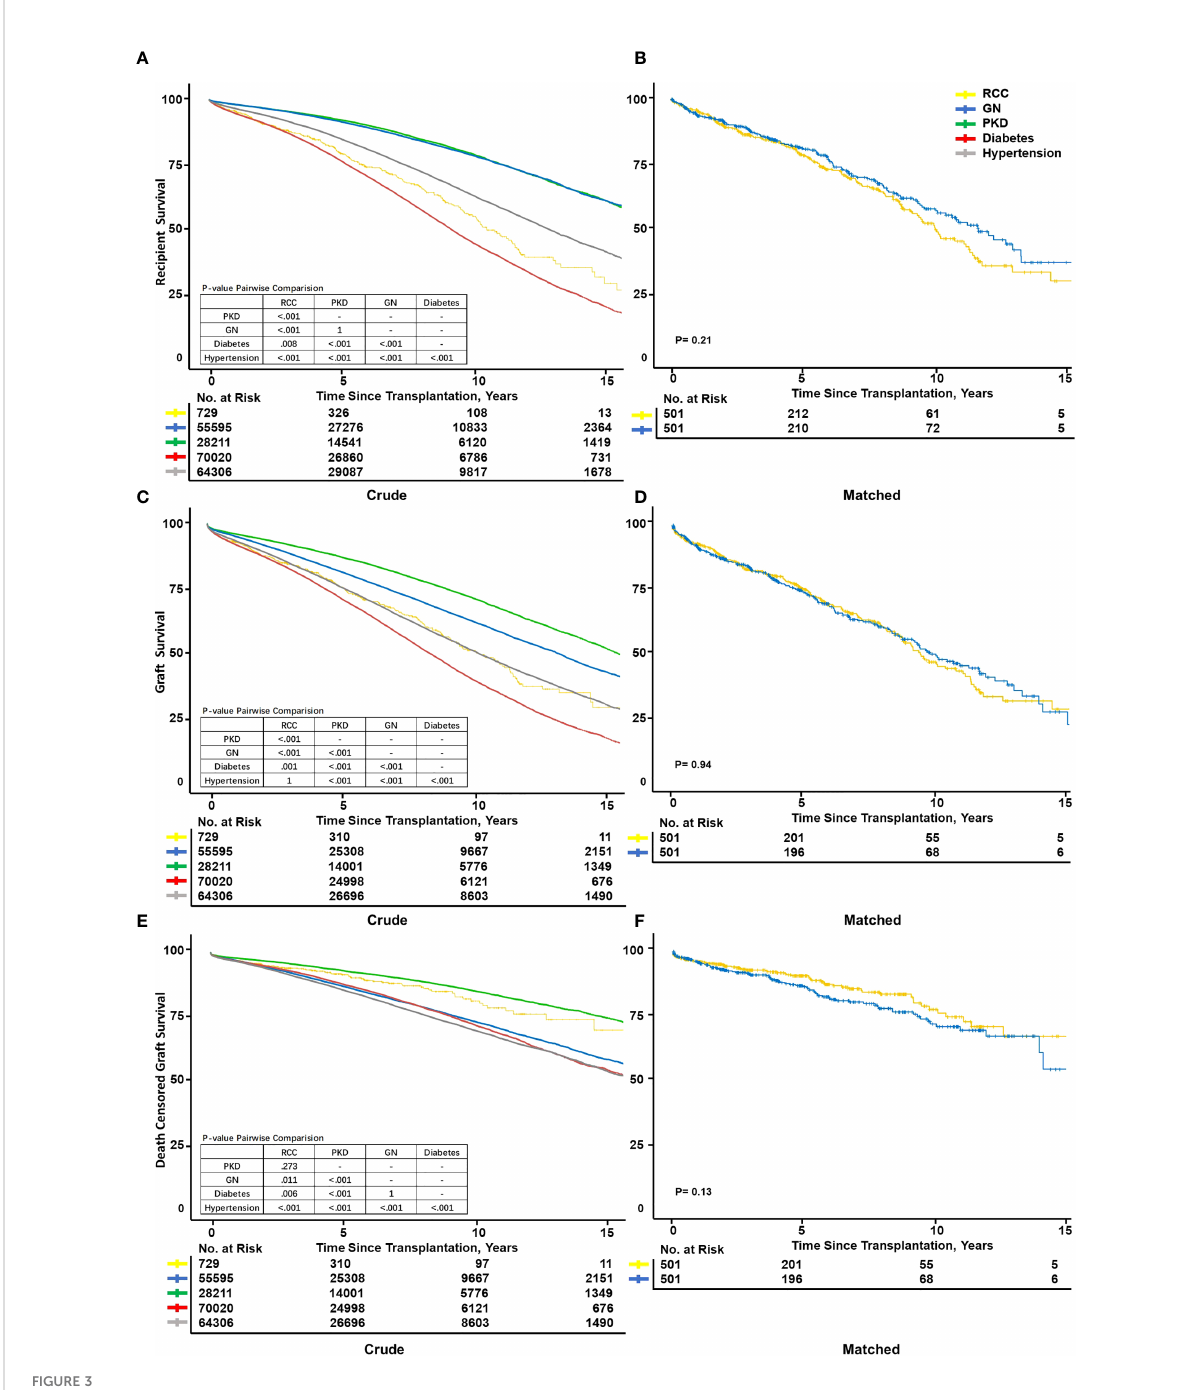
FIGURE 3 Kaplan – Meier survival curve fi t of recipient and graft survival. Kaplan – Meier survival curves showed patient survival between different primary diseases after transplantation before (A) and after (B) matching. Graft survival crude (C) and after matched (D) . Death-censored graft survival before (E) and after (F) propensity score matching. Exact matching variables: Age, ethnicity; not exact: Sex, body mass index, donor age, donor body mass index, donor smoking history, and donor hypertension